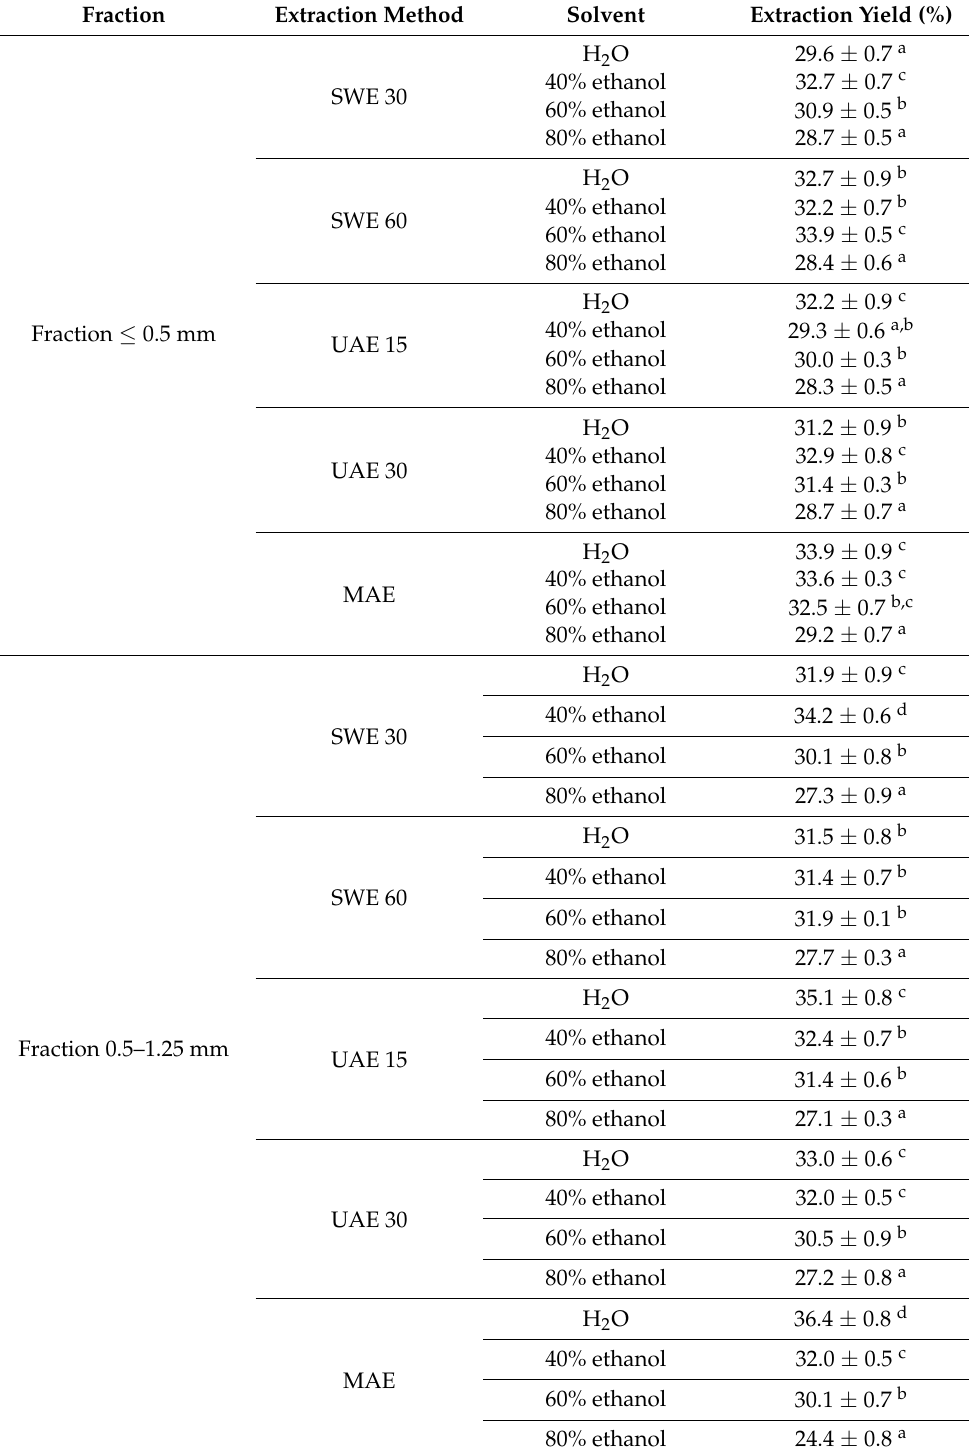
Table 1. Yield of extracts obtained with different methods from P. barbatus (Coleus forskohlii)